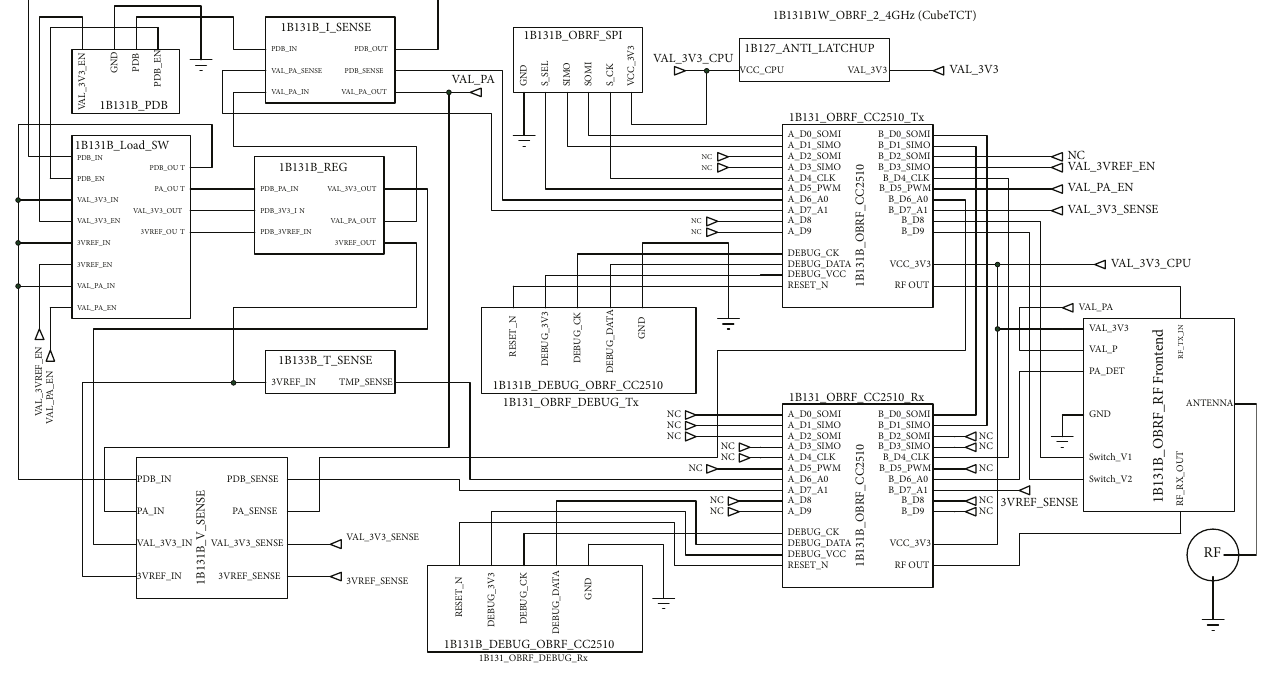
Figure 2: Mentor schematic of 1B31B1W_OBRF_2_4_GHz (CubeTCT) transceiver.